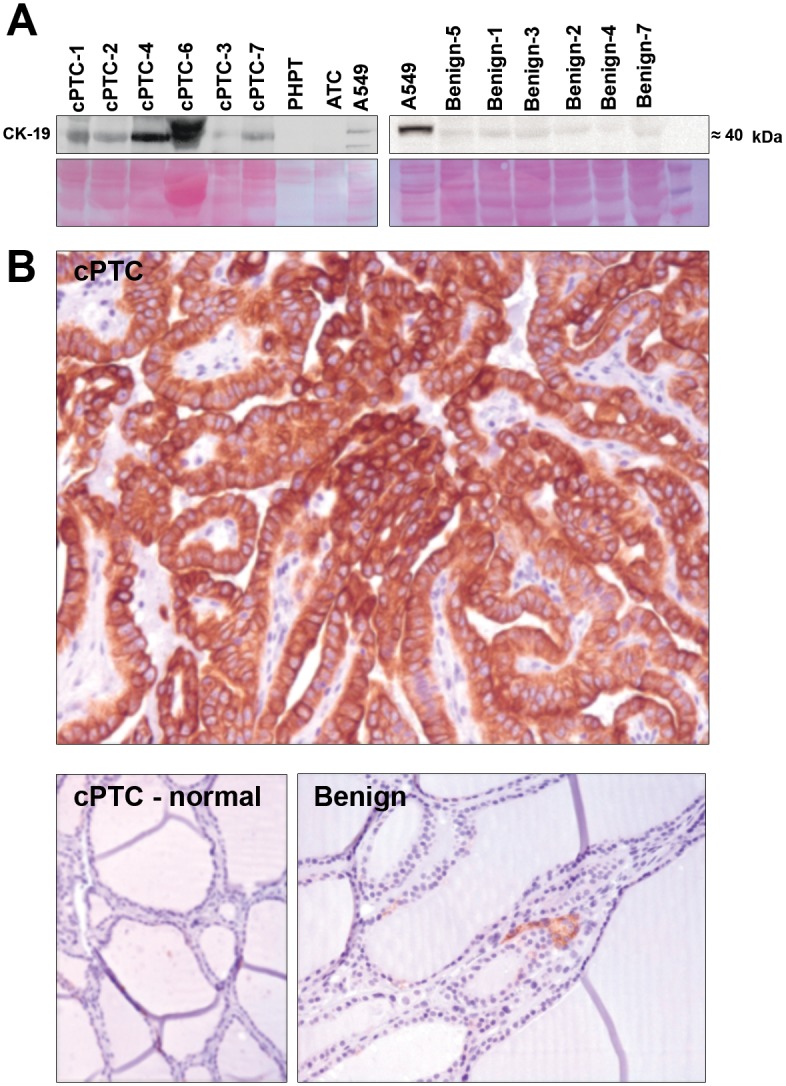
Expression of CK-19 in cPTC, benign cystic lesions and references.(A) Western blot analyses of CK-19 with depleted cyst fluids of cPTCs and benign lesions from the LC-MS/MS screening samples. Depleted cyst fluids of a parathyroid adenoma (PHPT), anaplastic thyroid carcinoma (ATC) and total protein extract from A549 cells are shown as reference. Representative transfer of proteins to nitrocellulose membrane stained with 0.1% Ponceau S solution used as loading control is shown below. (B) Immunohistochemistry showing CK-19 expression in cPTC tissue tumor cells but not in surrounding normal thyroid cells (cPTC—normal) or multinodular goiter (Benign).